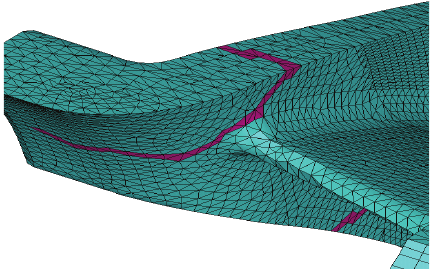
Figure 14: The hub crack initiation point and extending direction (𝑛𝑚 = 2000)